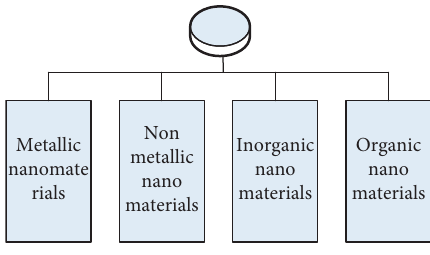
Figure 2: Classification of nanomaterials by materials. Figure 1: Classification by